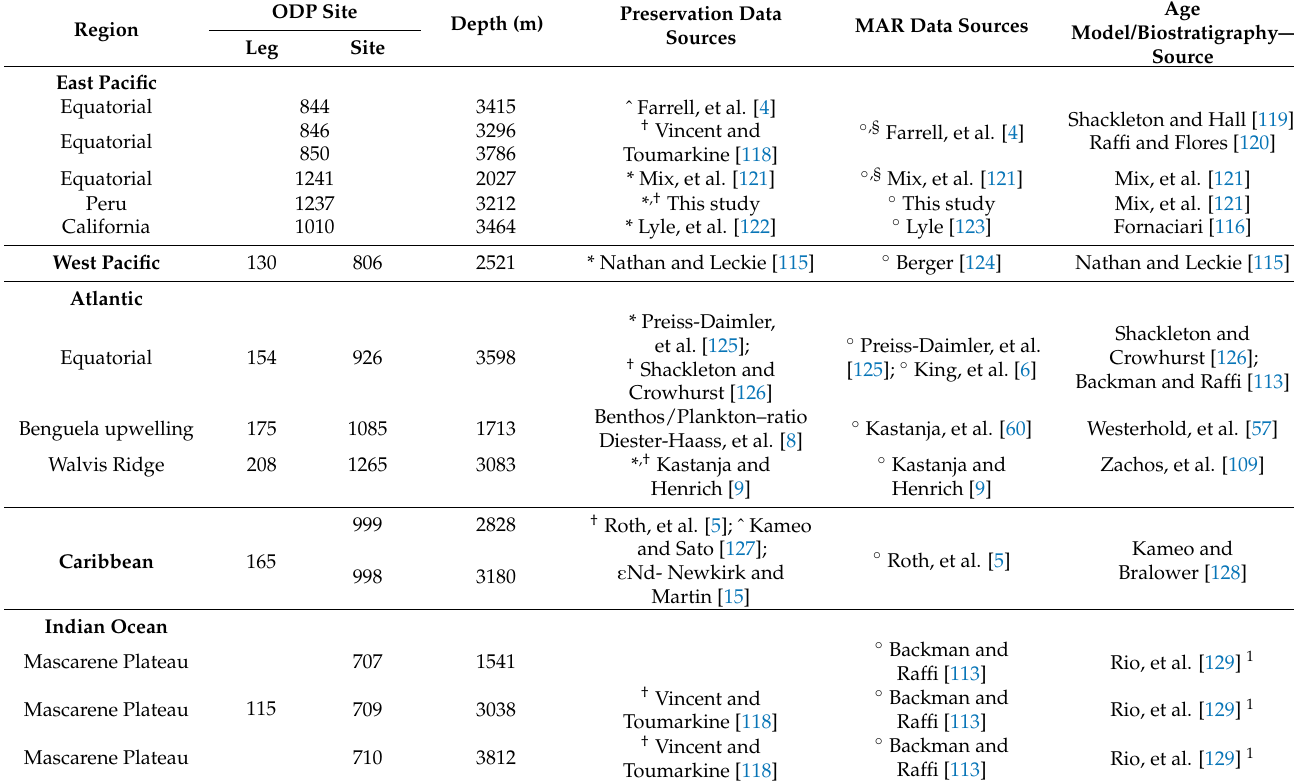
Table 1. Summary table of ODP legs and sites discussed in the present paper together with the bibliographic data sources for their chronostratigraphy, carbonate preservation and Mass Accumulation Rates. The symbols used to infer to the indexes are ˆ Nannofossil Preservation, * Foraminifer Preservation, † Coarse Fraction, ◦ MAR Carbonate , § MAR Opal .